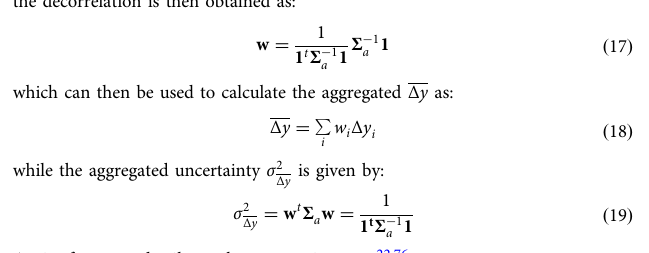
ffiffiffiffiffiffiffiffiffiffiffiffiffiffiffiffiffiffiffiffiffiffiffiffiffiffiffiffiffiffiffiffi σ 2 þ σ 2 A